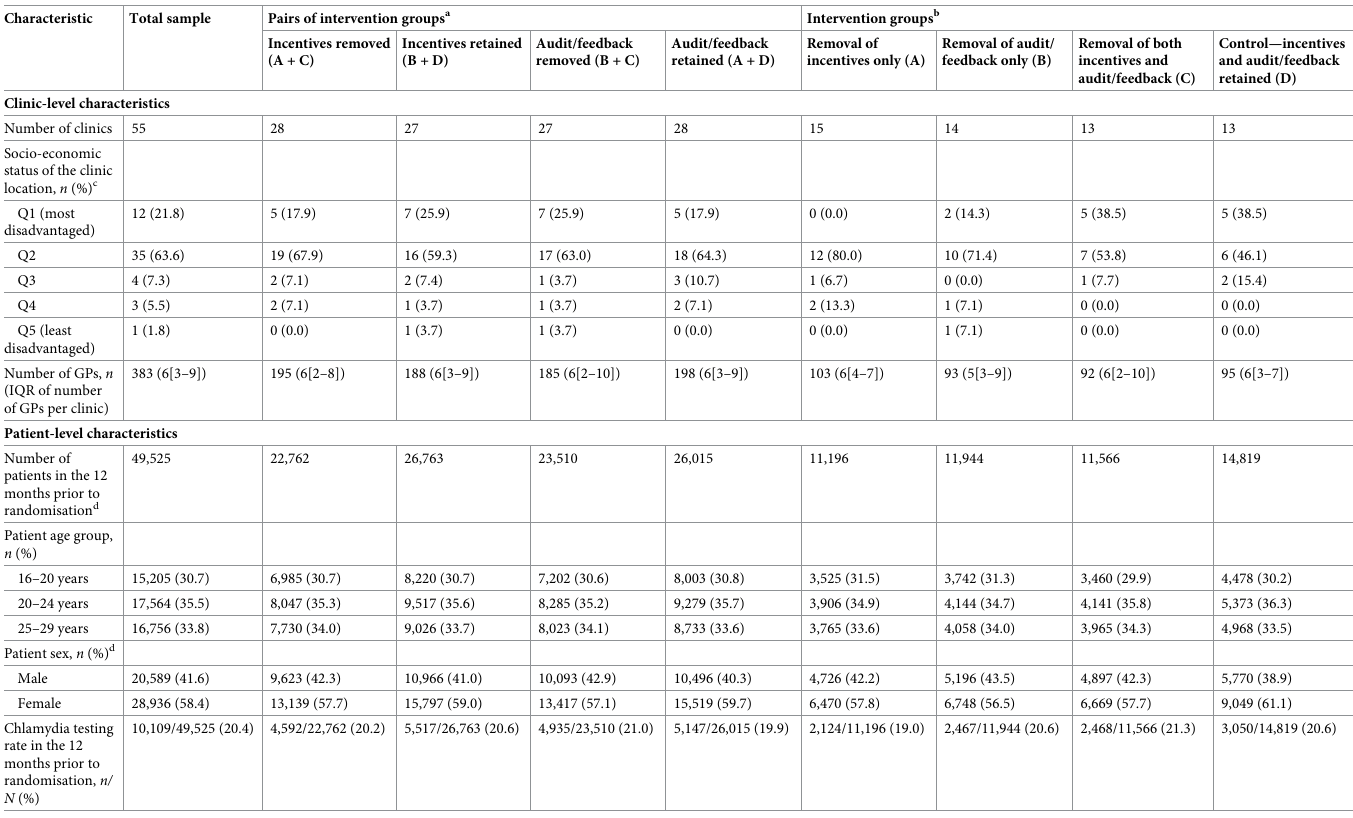
Table 1. Baseline characteristics of clinics and patients.